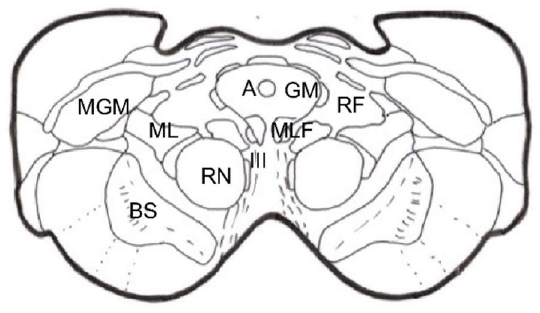
Central Gray. ML—Medial Lemniscus. RN—Red Nucleus. SN—Substantia Nigra. STT—Spinotha- lamic Tract. STrigT—Spinal Trigeminal Tract. Spinothalamic Tract. STrigT—Spinal Trigeminal Tract. lamic Tract. STrigT—Spinal Trigeminal Tract.